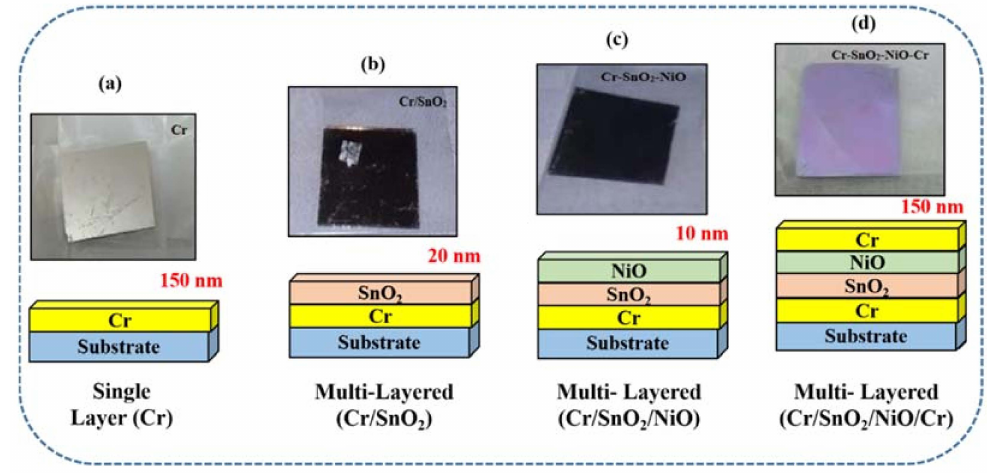
Figure 2. Schematic representation and illustrative photographs of ( a ) Cr, ( b ), Cr/SnO 2 ,